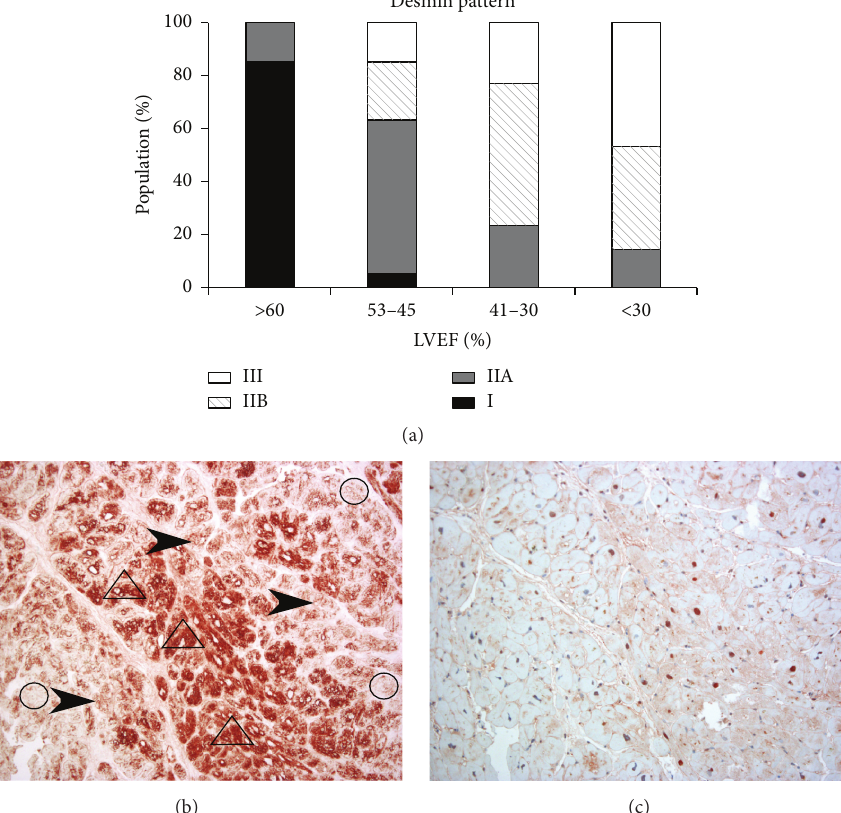
Figure4:Desminpatternincardiomyocytesoffailingheart.(a)Changesofdesminexpressionpatterninrelationtothedegreeofheartfailure. (b) A representative image showing the different types of desmin in the myocardium tissue of the patient’s heart in Group (II): increased expression (arrowhead), desmin forming granular clusters (in triangles), or desmin disappearance (in circle). (c) Expression of ubiquitin in serial tissue section shown in